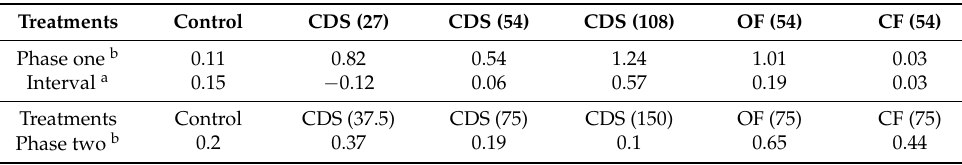
Table 5. Soil OM losses of the treatments in phase one and two